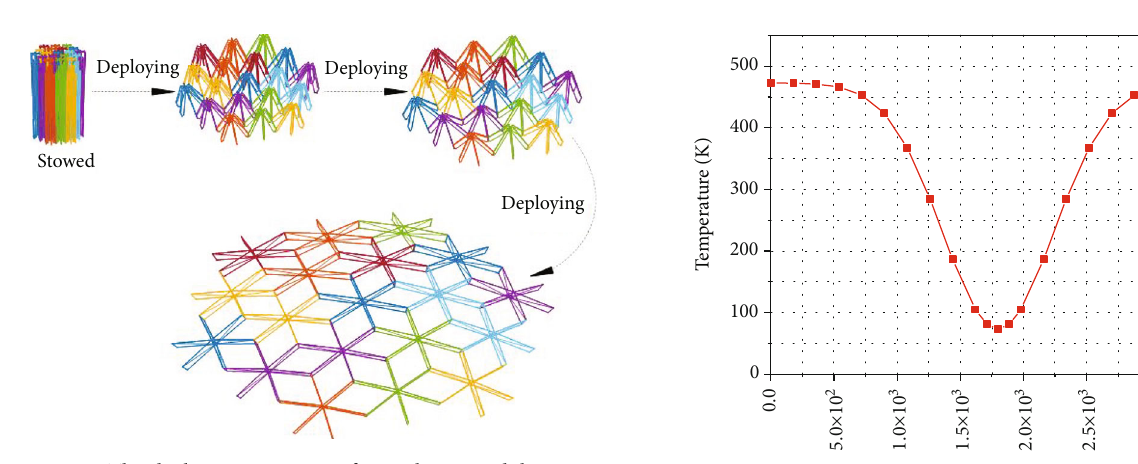
Figure 3: The deployment process of 3-circle 19-module antenna support structure (without cables).